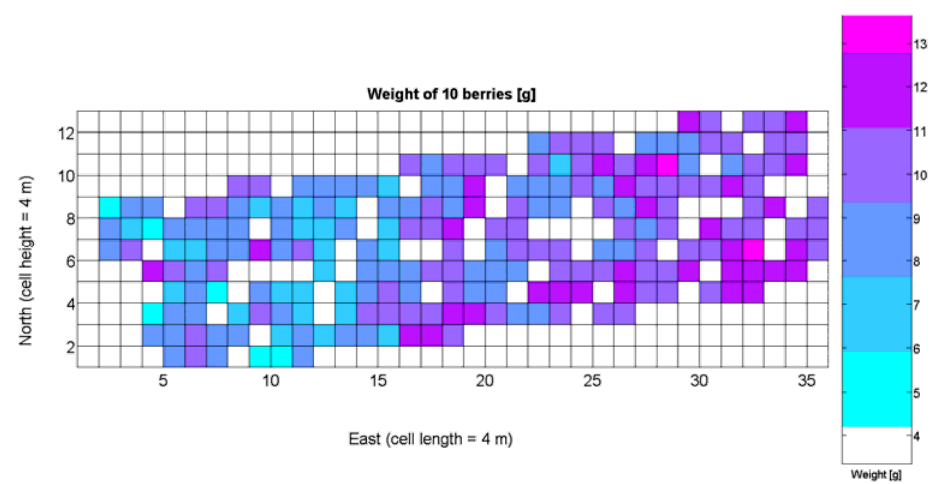
Figure 13. CB map of 10-berry weight